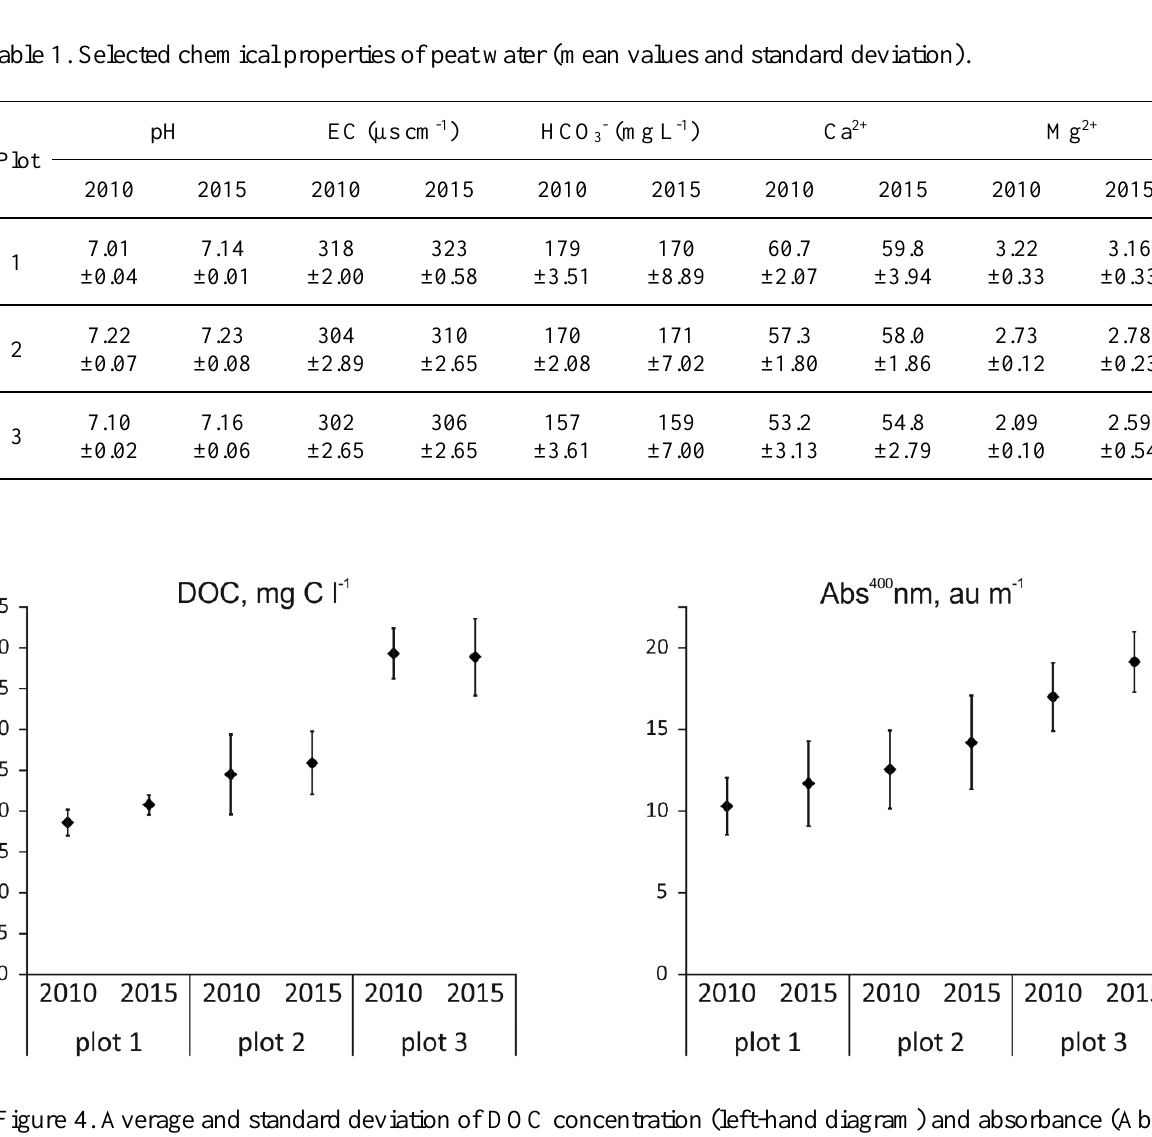
Figure 4. Average and standard deviation of DOC concentration (left-hand diagram) and absorbance (Abs) at 400 nm (right-hand diagram) in water. Comparison of data collected in 2010 and